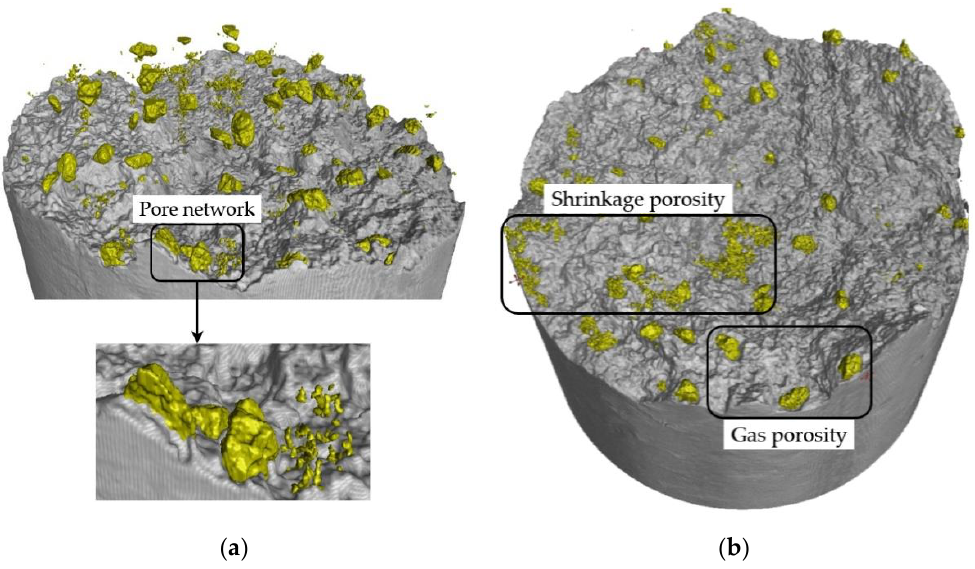
Figure 7. Fracture surface scanned by μCT: ( a ) Discontiguous crack-initiating pores (crack origin detected by SEM, specimen No. 09); ( b ) Exclusively pores on the fracture surface. (specimen No. 01).